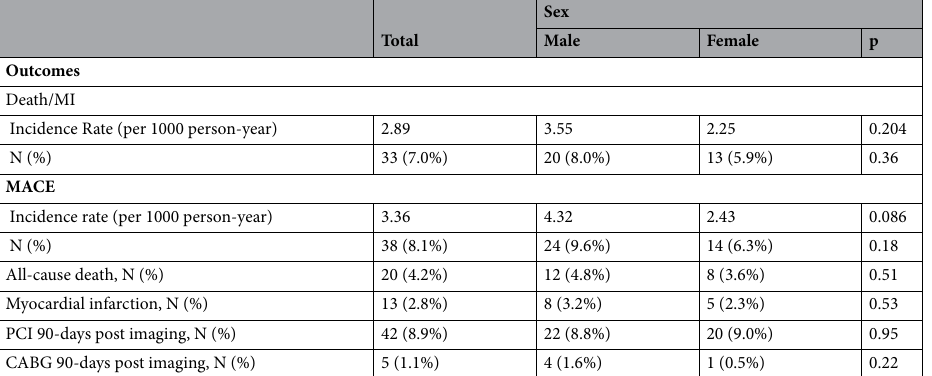
Table 3. Outcomes of the study population by sex. p-value comparing women and men was calculated using Student’s t test for continuous normally-distributed variables and median testing for continuous non-normally distributed variables or chi-square test for categorical variables. MACE major adverse cardiovascular events, MI myocardial infarction, PCI percutaneous coronary intervention, CABG coronary artery bypass graft.